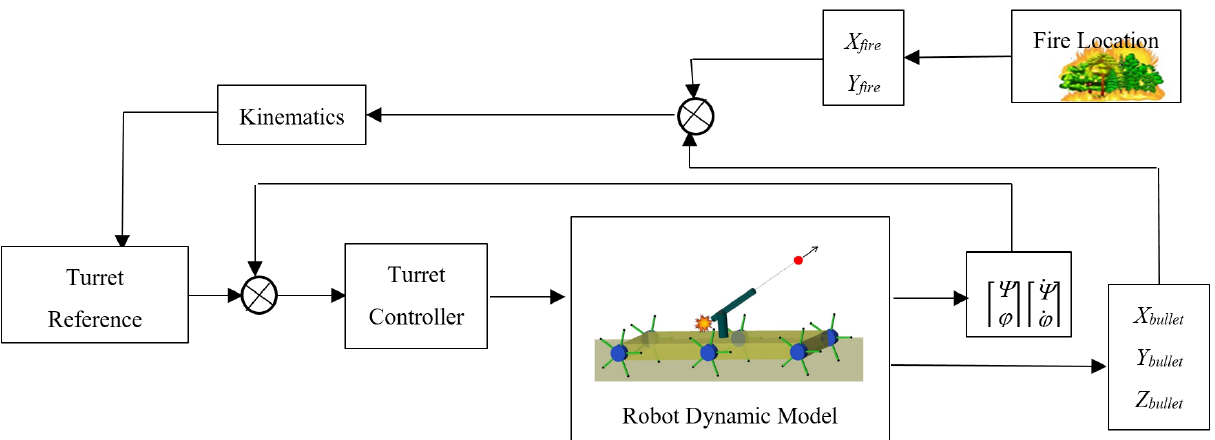
Figure 12. Schematic representation of firefighting robot SimMechanics Simscape multibody simulation model.